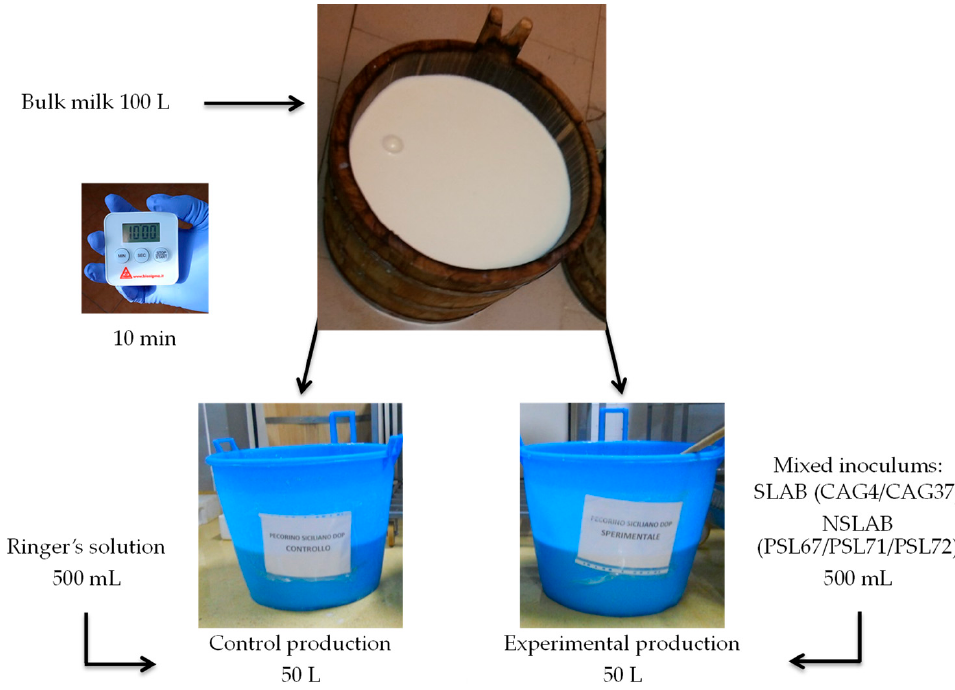
Figure 8. Working plan for PDO Pecorino Siciliano cheese production applied to test the starter/non-starter LAB inoculums at a large scale level.